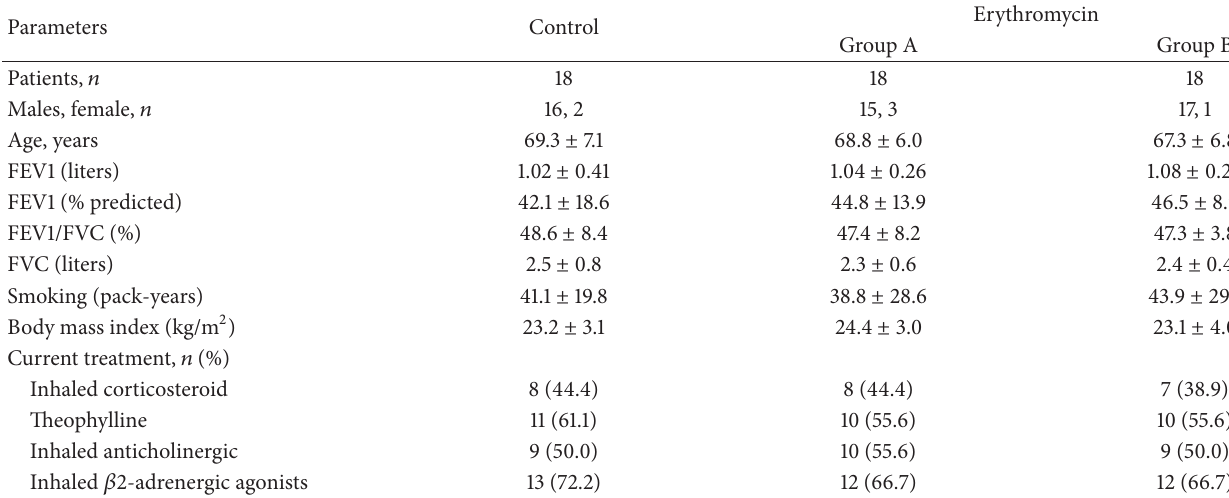
Table 1: Patients and baseline